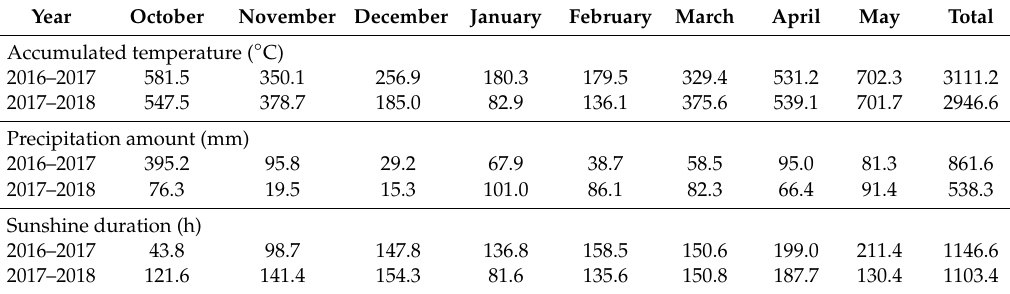
Table 1. Accumulated temperature, precipitation, and sunshine duration per month during the wheat-growing seasons from 2016 to 2017 and 2017 to